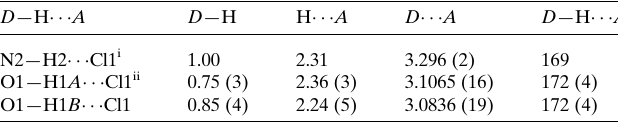
Table 1 Hydrogen-bond geometry (A˚ , (cid:5) ).